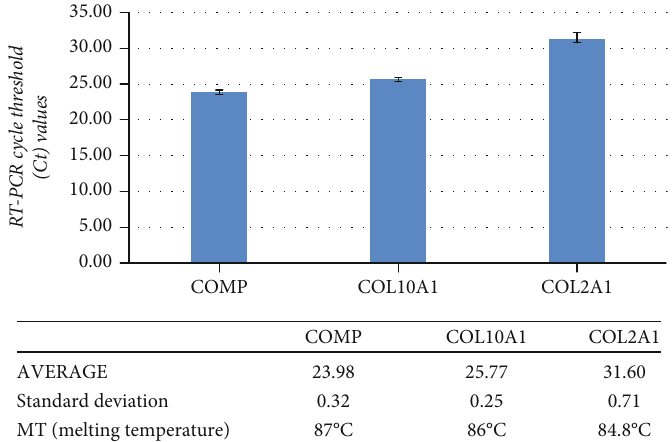
Figure 4: RT-PCR cycle threshold shows a positive expression for cartilage extracellular matrix genes: (a) the Cartilage Oligomeric Matrix Protein-COMP; (b) collagen type 1-COL10A1; (c) the collagen type 2-COL2A1.